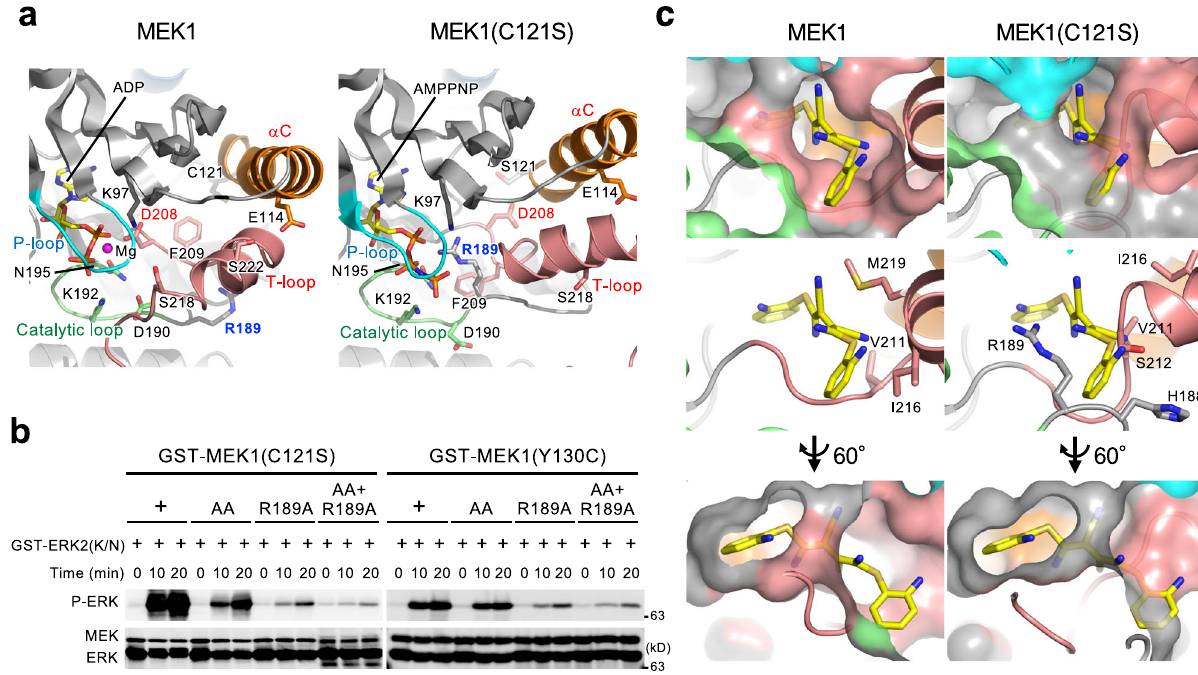
Fig. 3 MEK1(C121S) exhibits a unique ATP-binding property and deformity of the allosteric pocket. a , b R189 mediates ATP-binding in MEK1 mutants. a Close-up views around R189. The R189 side-chain in MEK1(C121S) is rotated towards the ATP-binding site and directly coordinates an ATP analog, AMPPNP. b In vitro kinase assay of recombinant proteins. The indicated MEK1 mutants were incubated with GST-ERK2(K/N). ERK phosphorylation was probed with an anti-P-ERK Ab. Source data are provided as a Source Data fi le. c Close-up views of the MEK1 allosteric pockets. The MEK inhibitor U0126 in the MEK1-U0126 complex (PDB: 3EQH) (left) is superimposed onto MEK1(C121S)